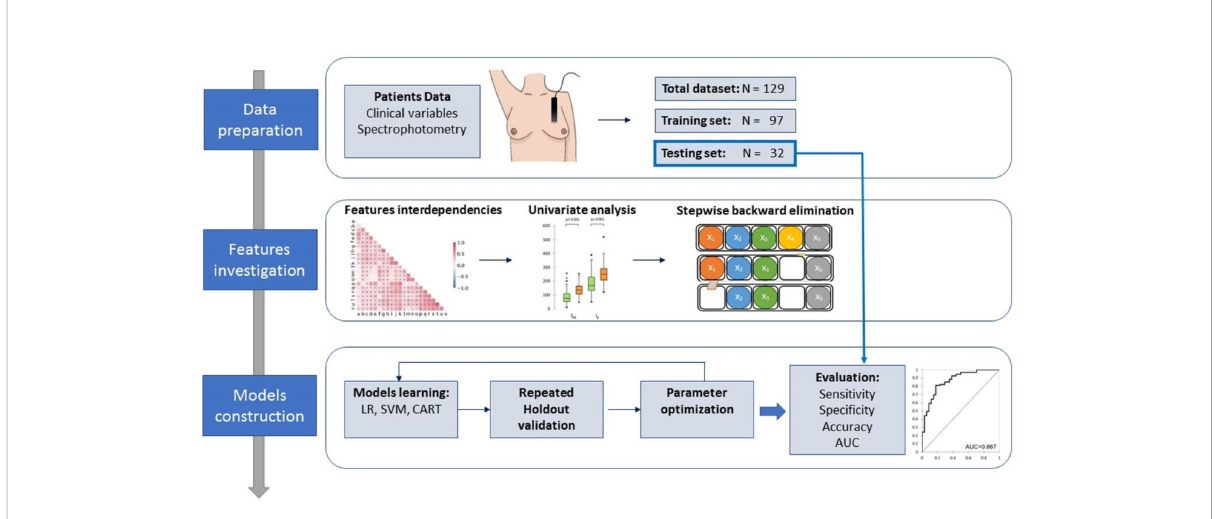
FIGURE 1 Schematic work fl ow and methodology of the